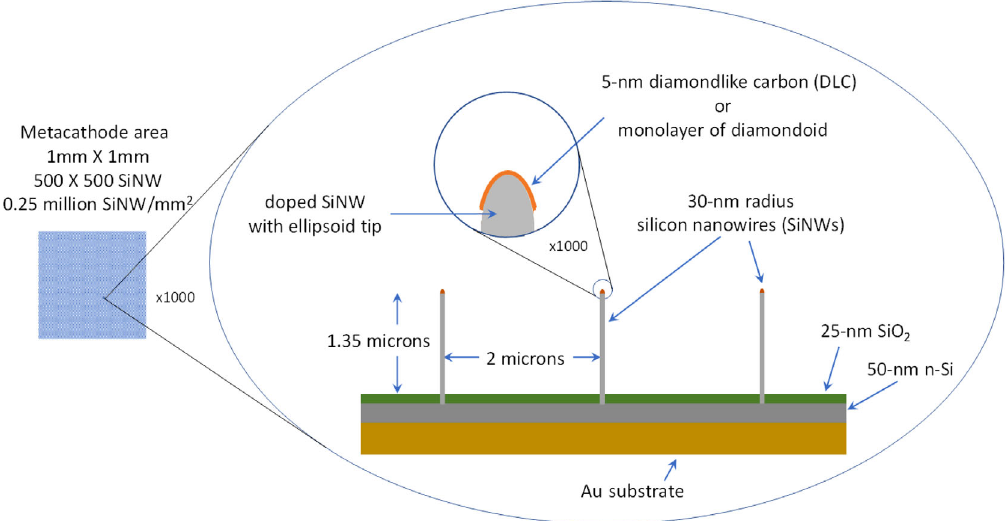
FIG. 13. Conceptual drawing of the